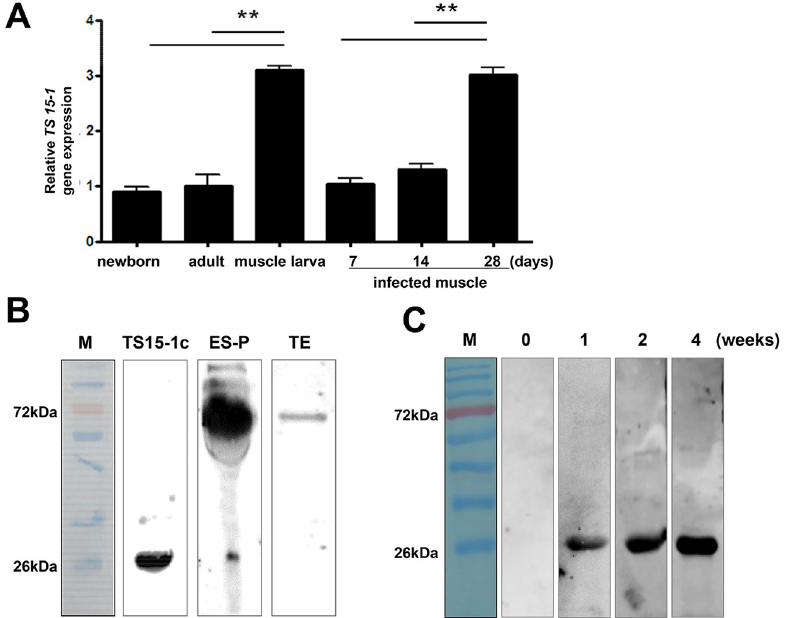
Fig 5. Expression levels of TS15-1 during developmental stages and T . spiralis infected muscle, and evaluation of TS15-1 antigenicity. (A) Larva from each stage, the adult worm, and T . spiralis infected muscle (7, 14 and 28 days after infection) were collected and TS 15–1 gene expression levels were analyzed with real-time PCR analysis. ( �� ; P < 0.01, these were representative results from three independent experiments). (B) The polyclonal α -TS 15-1c antibody was detected on TS15-1c, ES-P, and TE from T . spiralis or (C) sera of T . spiralis infected mice at 1, 2 and 4 weeks by western blot analysis. (M, molecular marker).